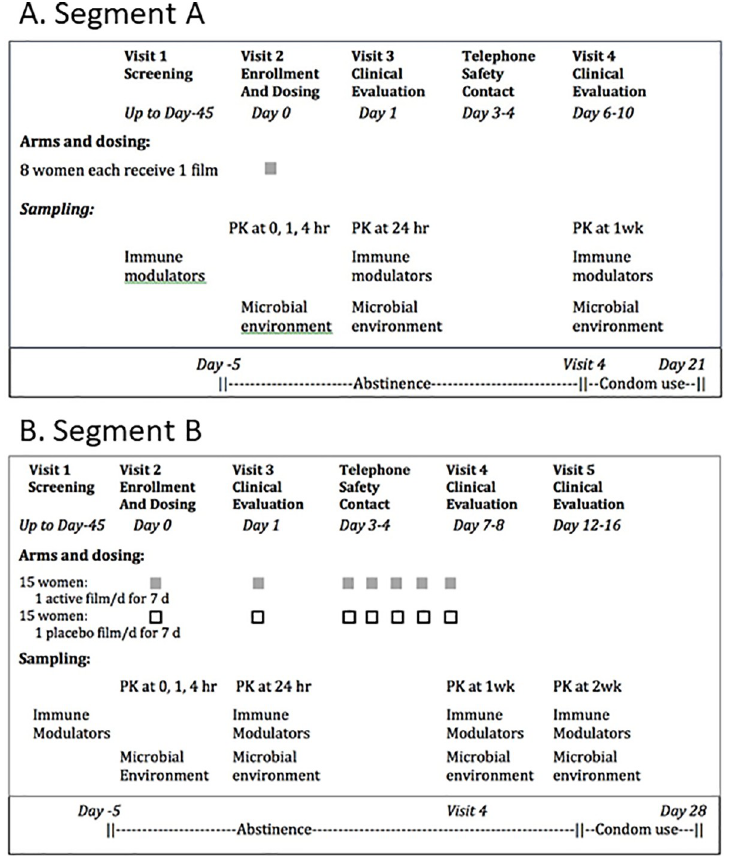
Fig 2. MB66-01 study Segments A and B schemata with target